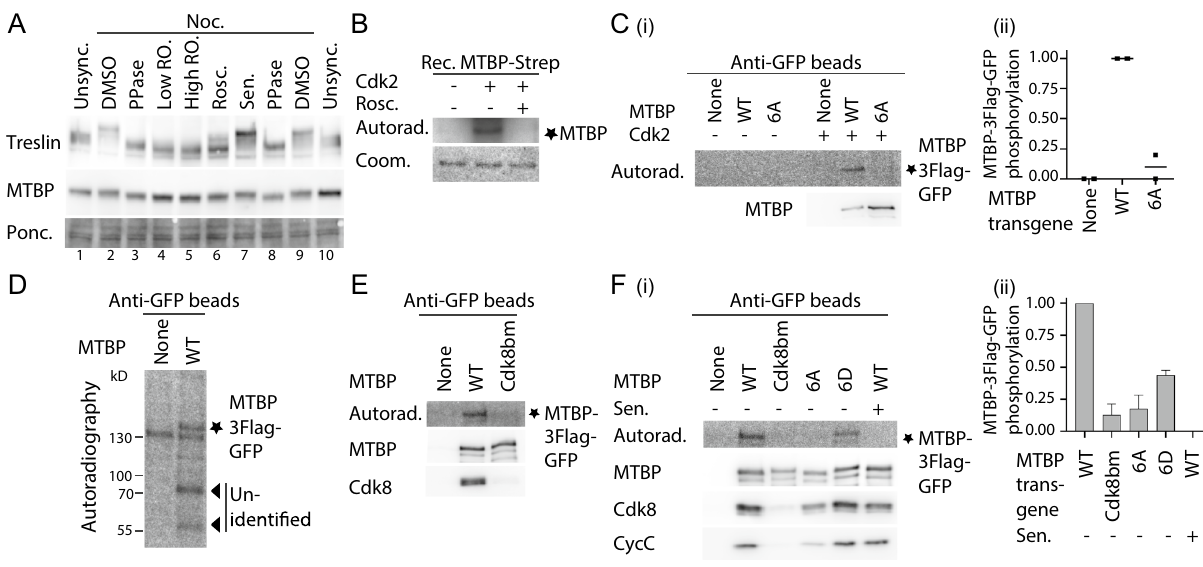
Figure 5. MTBP is phosphorylated by cell cycle CDK and Cdk8/19-cyclin C. ( A ) Phosphorylation-mediated gel shifts of MTBP and Treslin/TICRR in mitotic cells depend on M-CDK. Cells arrested in mitosis with nocodazole (Noc) or asynchronous cells were treated for 30 min with DMSO, low (9 µM) or high concentrations (90 µM) of RO-3306 (RO.), roscovitine (Rosc.) or senexin A (Sen.). After cell lysis lysates were treated with lambda phosphatase (PPase) where indicated before immunoblotting using antibodies against MTBP (12H7) and Treslin/TICRR (148). ( B ) In vitro phosphorylation of MTBP by S-CDK. Recombinant 6His-Treslin/ TICRR-aa1-1258-MTBP-Strep was incubated with Cdk2-cyclin A in the presence of γ ‐ 32 P ‐ ATP and DMSO or CDK inhibitor roscovitine and detected by autoradiography. Coomassie staining controlled loading (Load.). Rec., recombinant. ( C ) S-CDK phosphorylation of MTBP depends on CDK consensus sites. C-terminally 3xFlag-TEV2-GFP-tagged MTBP-wild type (WT), MTBP-6A or control plasmid were transiently transfected into 293T cells before anti-GFP IP, incubation with buffer or Cdk2-Cyclin A in the presence of γ ‐ 32 P ‐ ATP, and detection by autoradiography and immunoblotting using an antibody against MTBP (12H7). (i), autoradiogram; (ii), quantification of signal intensities of two independent replicates. WT signals were assigned the value 1 and control plasmid 0. MTBP-6A, amino acid exchanges S539A, T635A, S639A, S703A, S707A, T799A. ( D , E ) MTBP phosphorylation depends on binding to Cdk8/19-cyclin C. Native lysates of cells transfected as in C were immunoprecipitated and incubation with γ ‐ 32 P ‐ ATP before detection by autoradiography or immunoblotting using an antibody against MTBP (12H7) and Cdk8. ( F ) Native lysates of cells transfected with the indicated MTBP versions and with Cdk8-cyclin C were analysis as in D in the presence of DMSO or Cdk8 inhibitor senexin A. (i), autoradiogram; (ii), quantification of signal intensities of three independent replicates. WT signal intensities were assigned the value 1 and Cdk8 inhibitor treatment